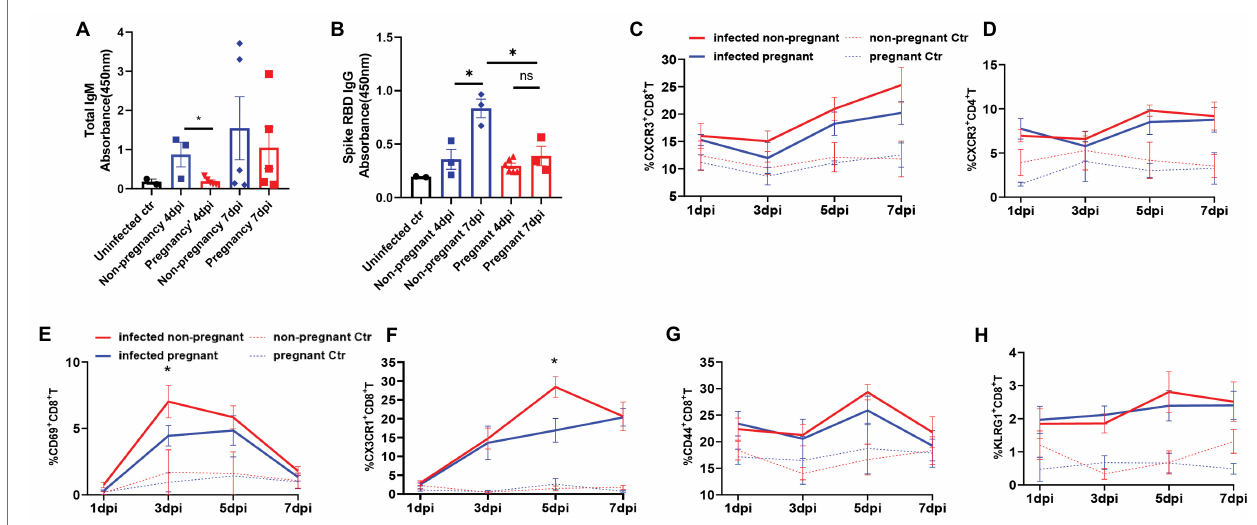
FIGURE 5 | The production of antibodies and the activation of T cells. Total IgM (A) or SARS-CoV-2 spike receptor-binding domain (RBD) IgG (B) in plasma of mice was detected. The absorbance of OD 450 nm was compared between the pregnant and non-pregnant groups during 4–7 dpi ( n ≥ 3 per each group, unpaired t -test, * p < 0.05, ns p > 0.05). The gates of flow cytometry (FCM) are shown in Supplementary Figure 4 . The T cell subsets at 1, 3, 5, and 7 dpi were analyzed by flow cytometry between infected non-pregnant mice (red line) and that of pregnant mice (blue line; C–H , n ≥ 3 per each group). (C) %CXCR3 + CD8 + T cells. (D) %CXCR3 + CD4 + T cells. (E) %CD69 + CD8 + T cells. (F) %CX3CR1 + CD8 + T cells. (G) %CD44 + CD8 + T cells. (H) % KLRG1 + CD8 + T cells. (C–H) Unpaired t -test and Welch’s t -test were used. * p < 0.05, ns p >